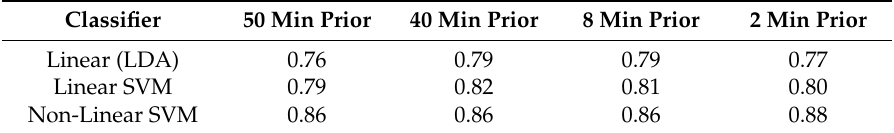
Table 3. Area under the receiver operating characteristic (ROC) curves generated for each